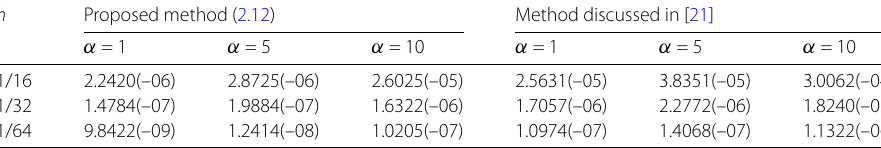
Table 8 Problem 8.8: The maximum absolute errors